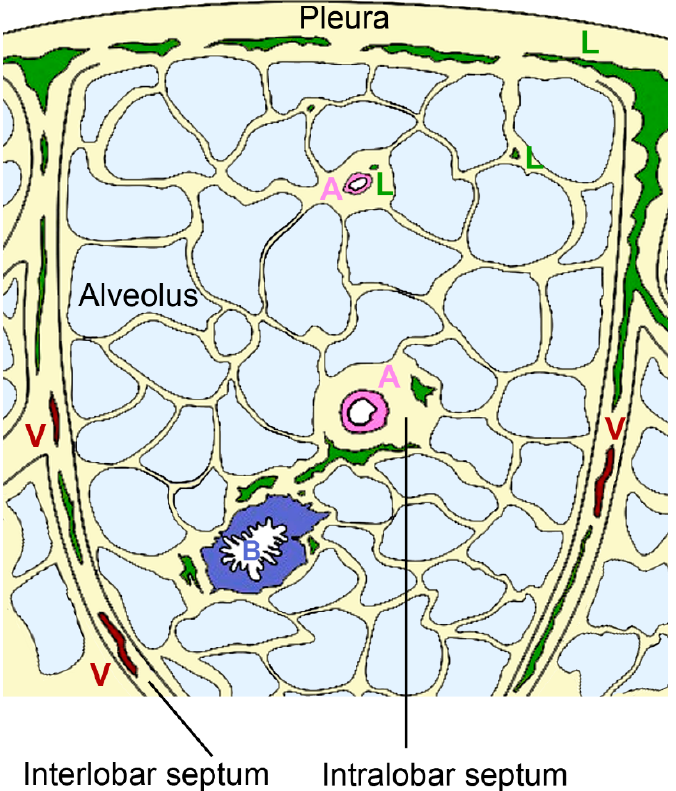
Figure 4. Organization of pulmonary lymphatics. Interlobular lymphatics (L) start at the pleura and follow the veins (V) in the interlobular septa. Lymphatic vessels are also found in bronchovascular bundles that contain bronchus (B) and artery (A) in the perivascular space of arteries of intralobular septa and independent from vessels in interalveolar septa.